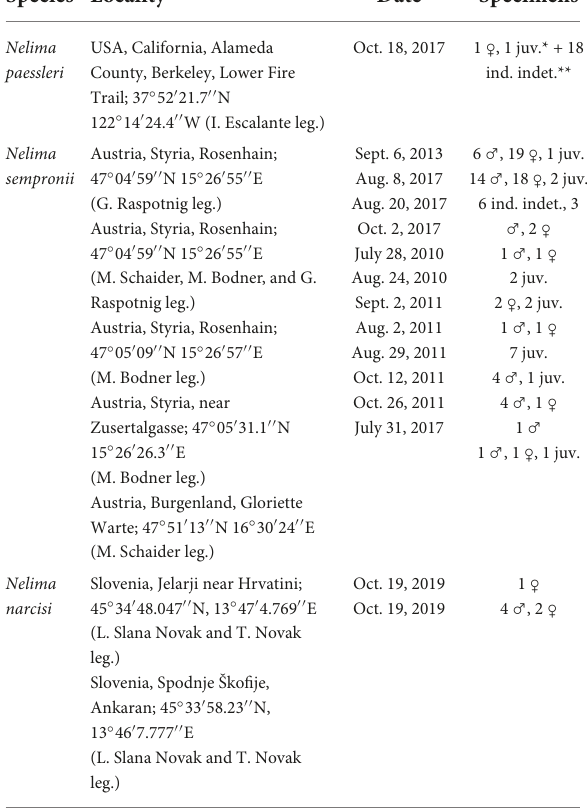
TABLE 2 Collection data.